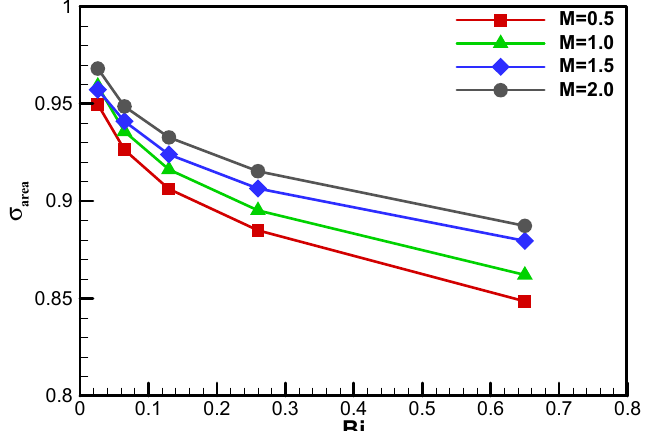
Figure 16. Influence of Biot number on area-averaged overall cooling effectiveness uniformity coefficient at M = 0.5–2.0.